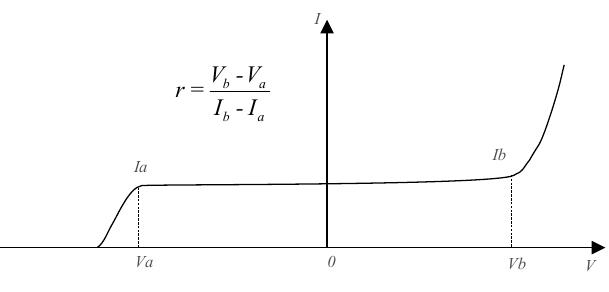
Figure 2. The dynamic resistance of the current source.